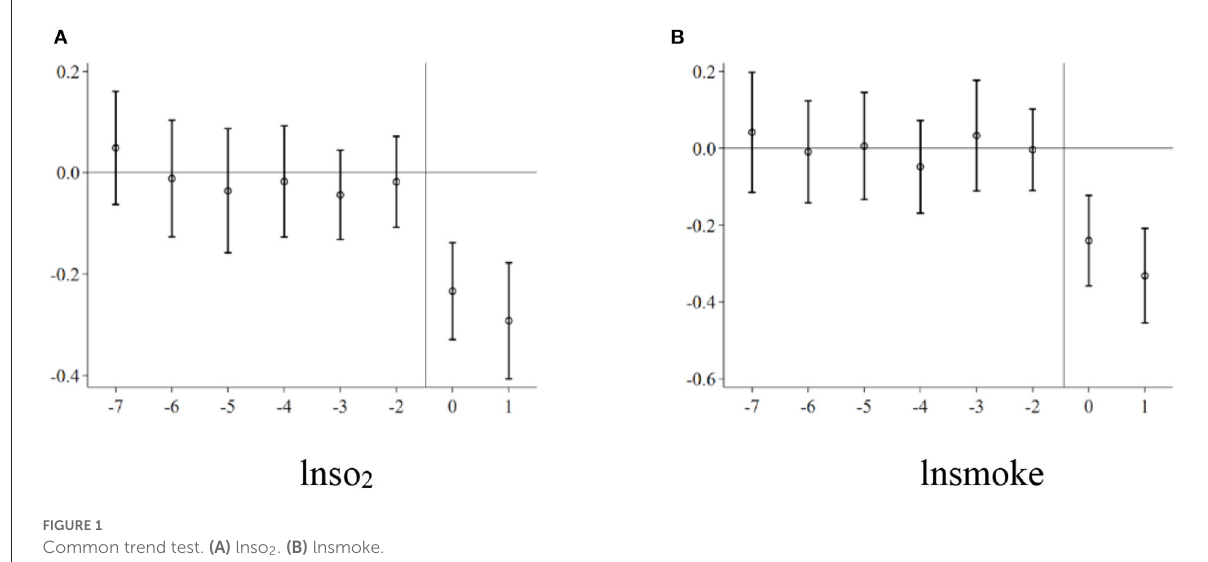
FIGURE1 Common trend test. (A) lnso 2 . (B) lnsmoke.